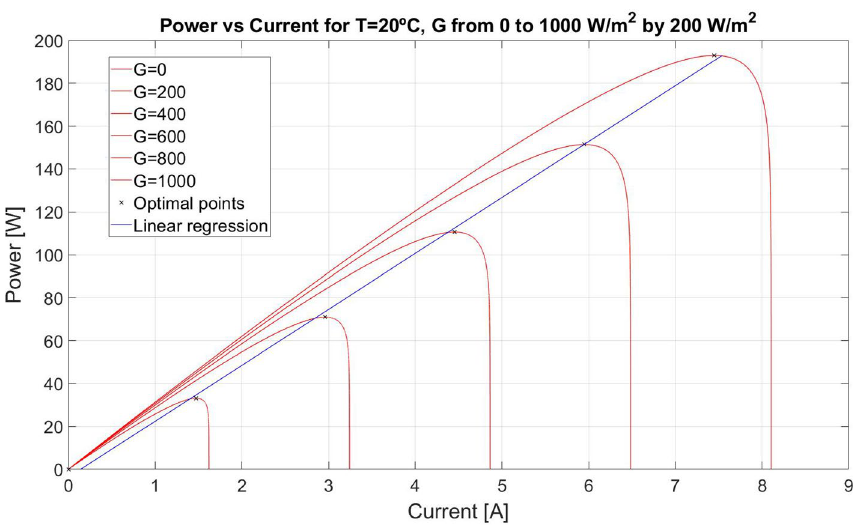
Figure 3. Maximum power vs optimal current for 20